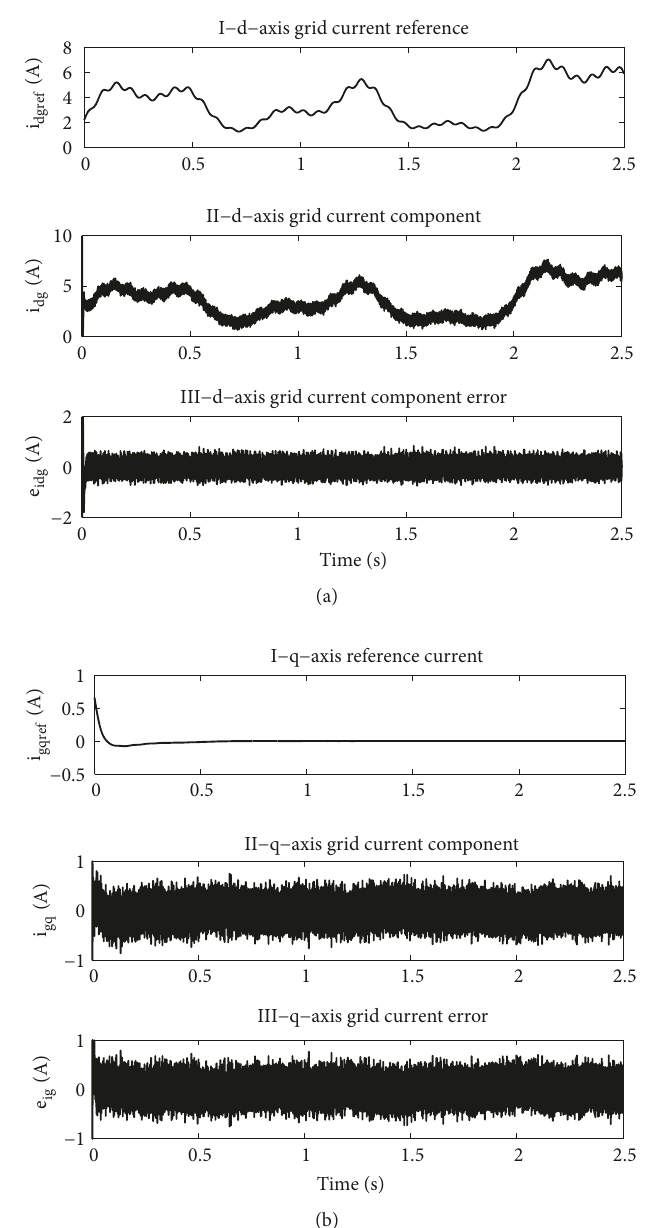
Figure 9: Performances of the grid side PI controllers in grid connected mode. (a) d-axis grid current reference (i), d-axis grid current component (ii), and d-axis grid current error (iii). (b) q-axis reference current (i), q-axis grid current component (ii), and q-axis grid current error